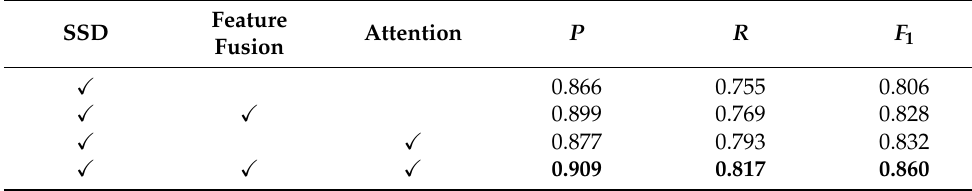
Table 2. Results of the ablation experiment.